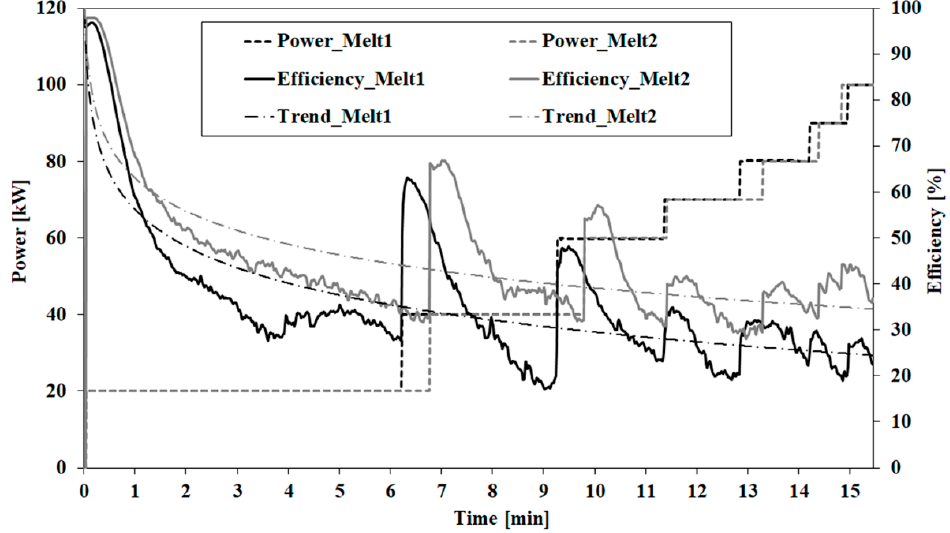
Figure 6. Each melting trial real-time thermal efficiency evolution.